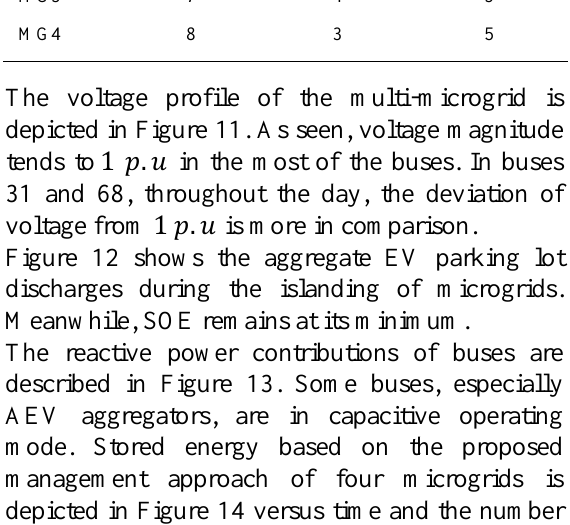
Figure 14. Stored Energy of four